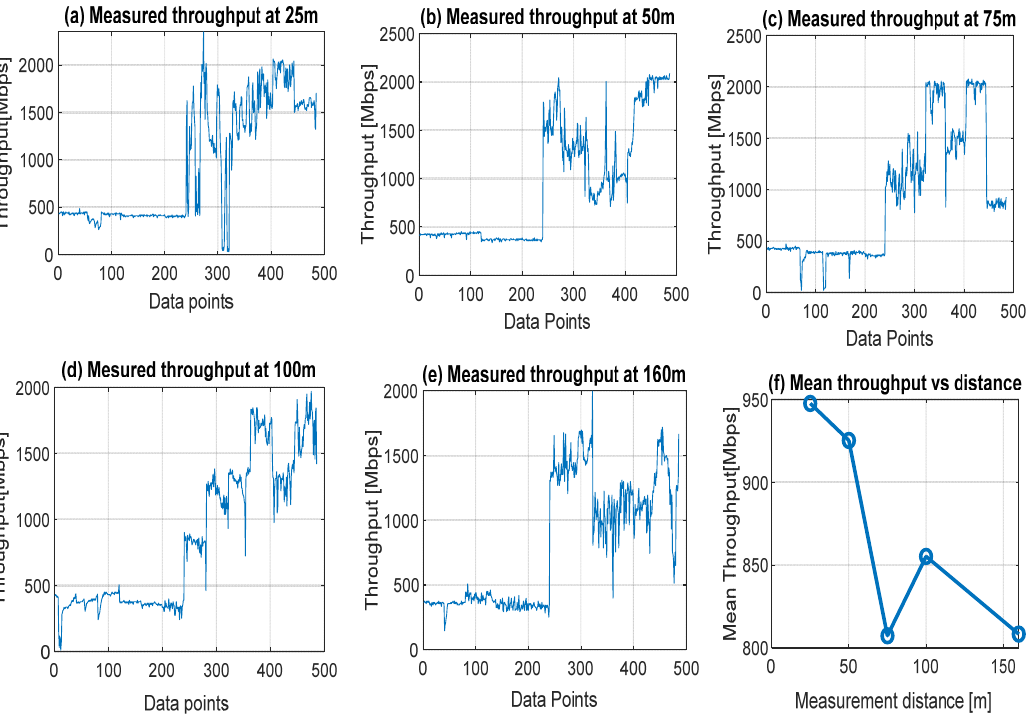
Figure 2. Measured throughput qualities attained at close communication distances of 25, 50, 75, 100, and 160 m between the transmitter and UET. Table 2. Throughput quality status attained from 25 to 160 m UET communication distance. Distance (m) Max.